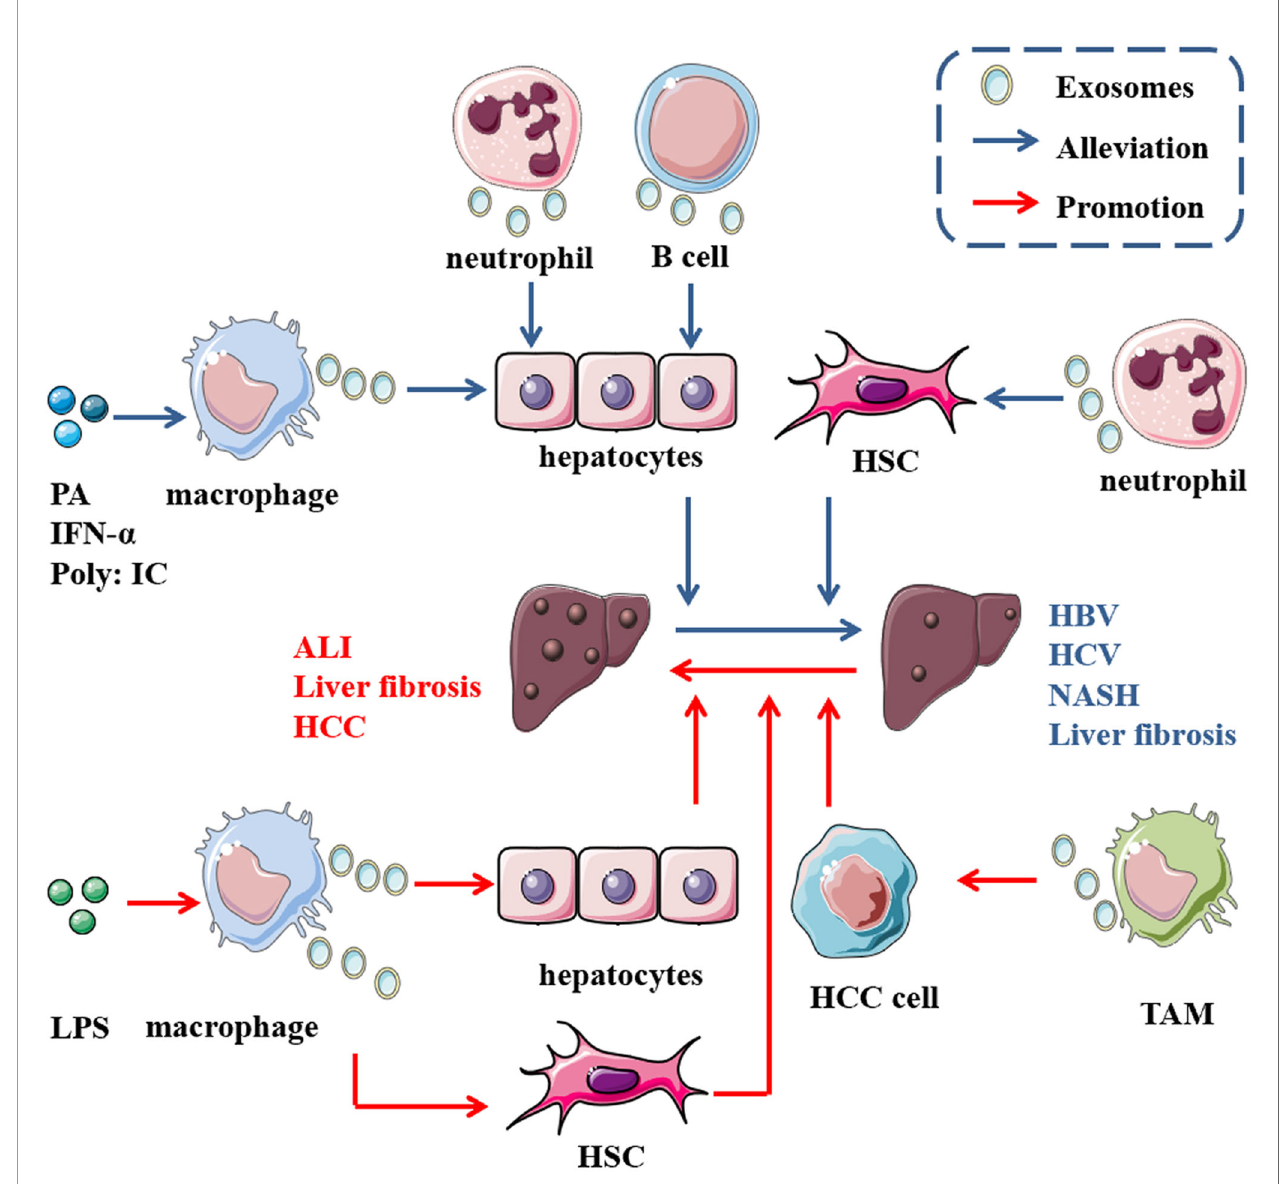
FIGURE 2 | Role of exosomes derived from immune cells in liver diseases. In the presence of some molecules, immune cells release exosomes carrying multiple cargoes to act on some cells in the liver, such as hepatocytes, HSCs and liver cancer cells, thus promoting the progression of (the red arrow) or alleviating (the blue arrow) some diseases in the liver. For instance, abundant miR-223 encapsulated in neutrophil-derived EVs can be taken up by both hepatocytes and active HSCs, thus ameliorating NASH and hindering steatosis to NASH progression. Additionally, miR-155 from B cells inhibits HCV replication in hepatocytes through exosome